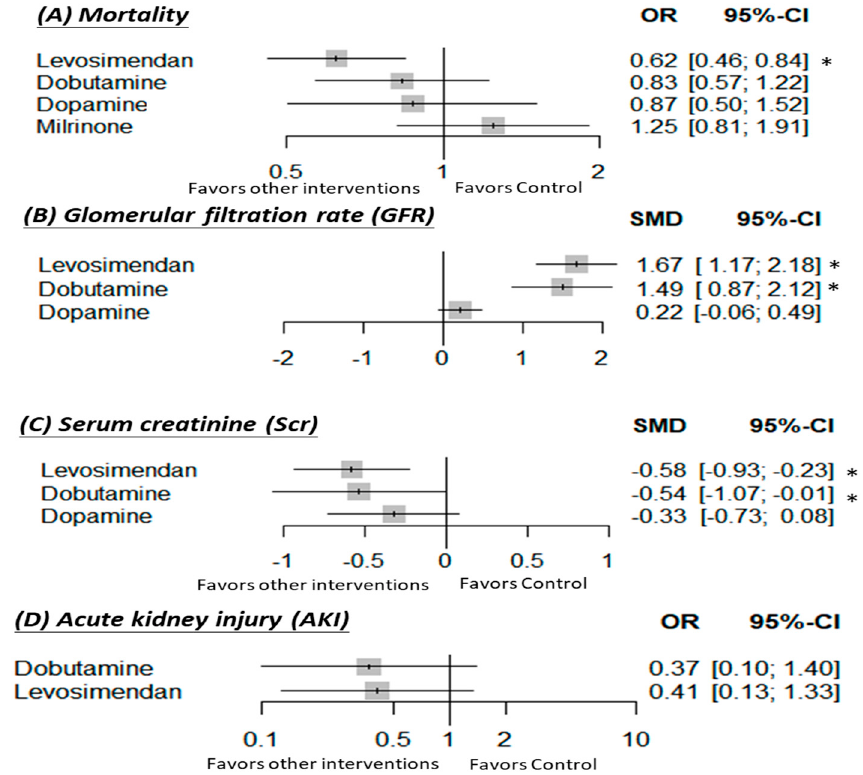
Figure 2. Forest plots of the overall network meta-analysis. Interventions were compared with the control for ( A ) mortality, ( B ) GFR, ( C ) Scr, and ( D ) AKI. CI: Confidence interval; OR: Odds ratio; SMD: Standardized mean difference. The control group was defined as a non-active treatment including an additional diuretic regimen or placebo. * Significant results.